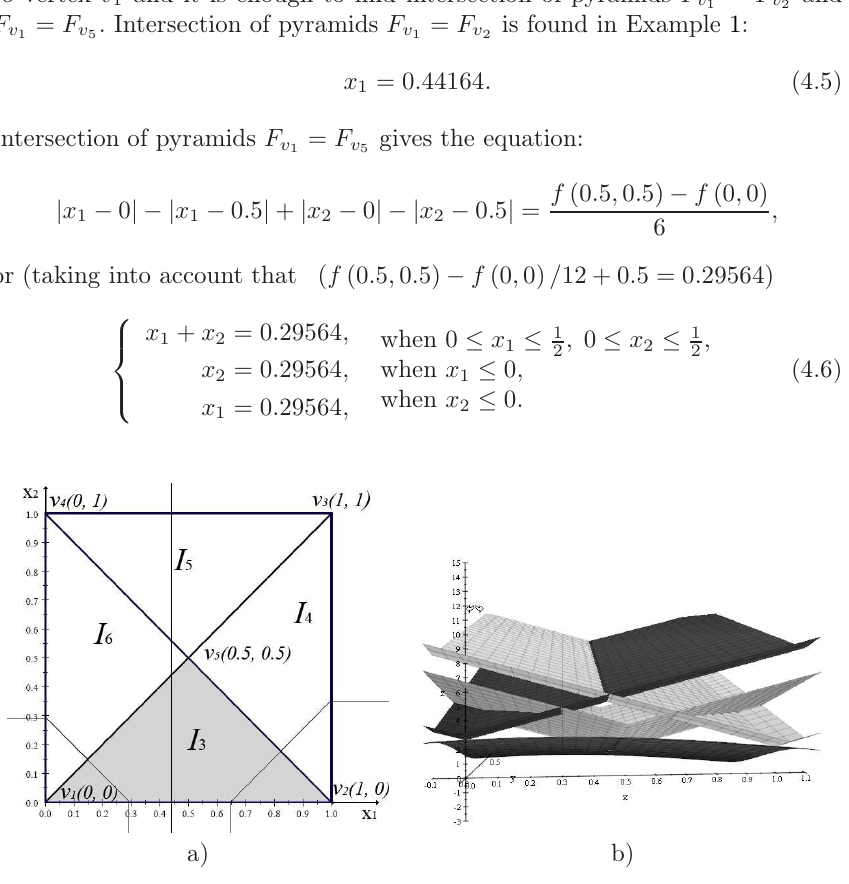
Figure 2. a) Projection of intersection lines; b) Visualization of upper bounding